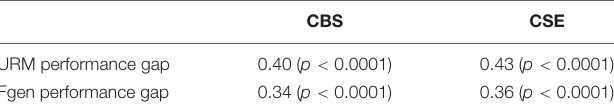
TABLE 4 | URM and first-generation (Fgen) performance gaps in exam performance across the College of Biological Sciences (CBS) and the College of Science & Engineering (CSE) measured by standard deviations from class means.